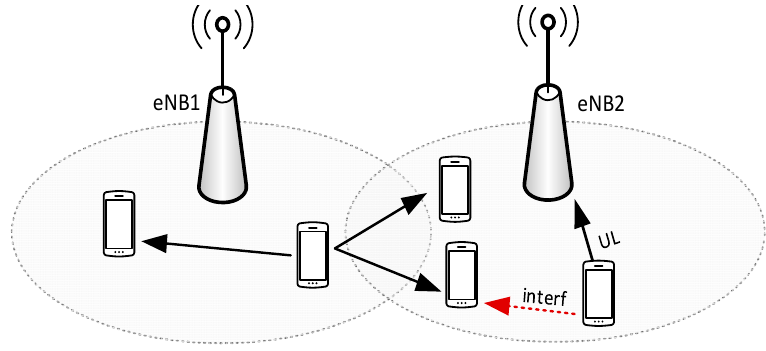
Figure 6. Multicell scenario. UL: uplink.